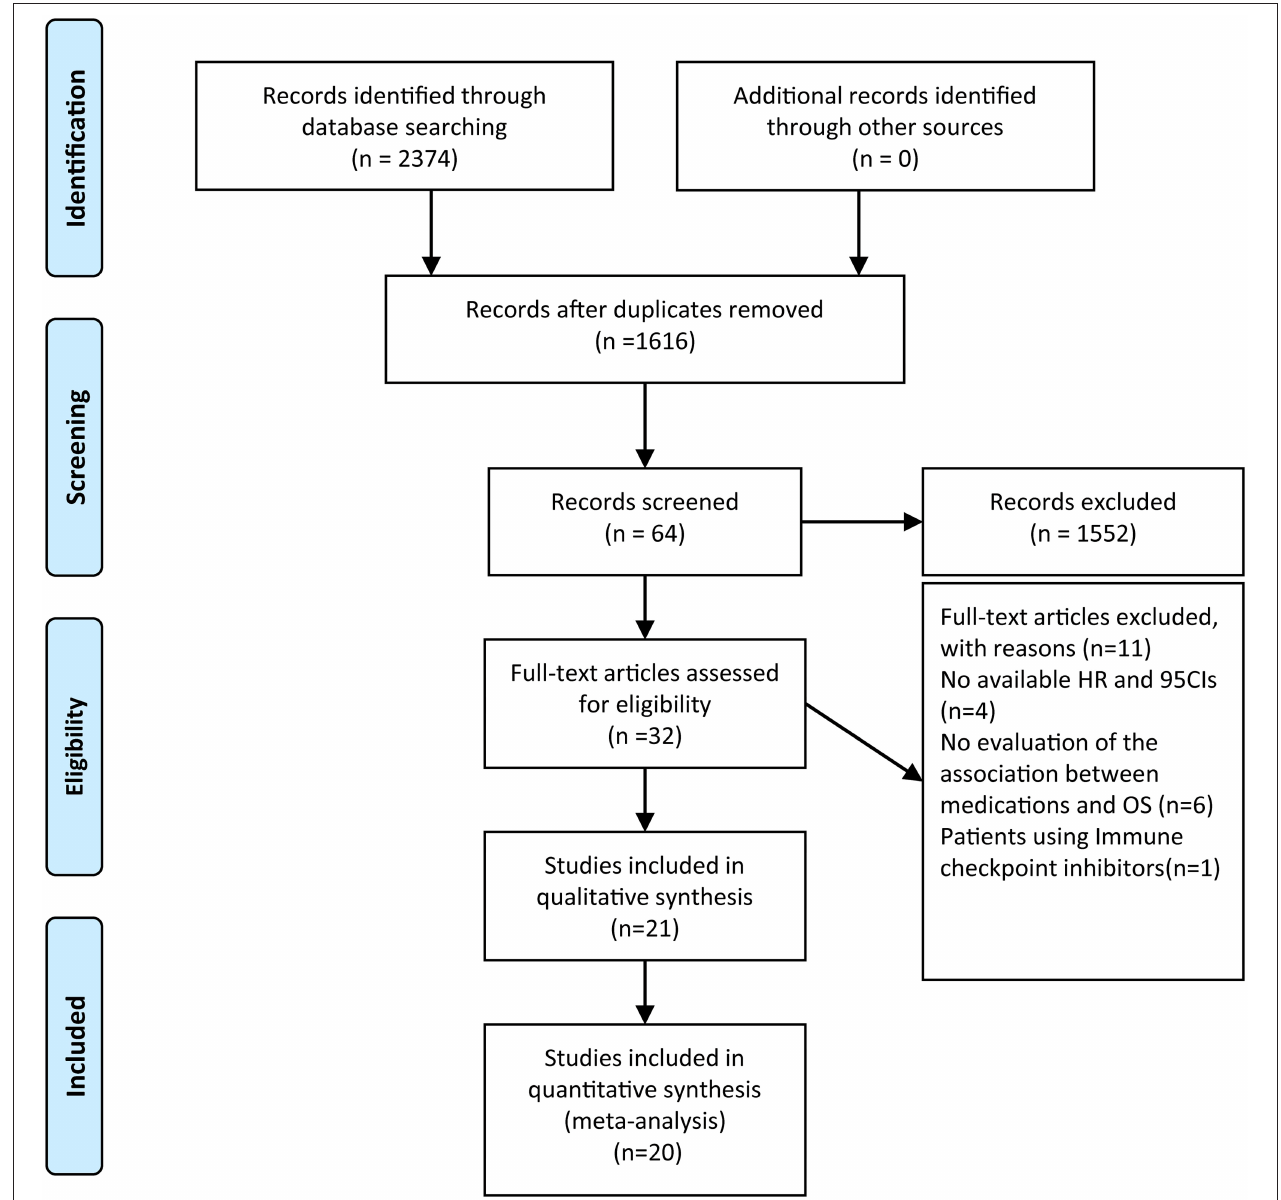
FIGURE 1 | Flow chart of literature search and study selection. After carefully reviewed 21 studies were included in the final systematic review and 20 in the quantitative analysis.